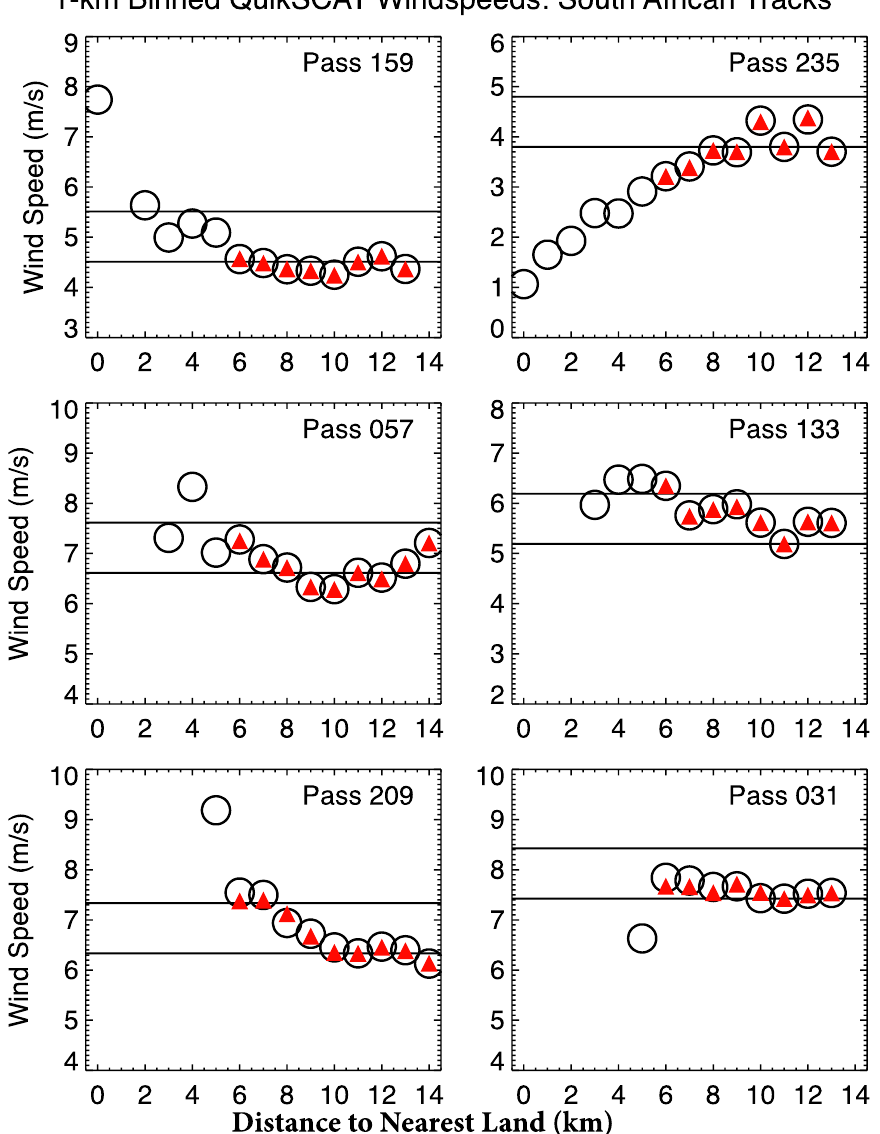
Figure 8. Scatterometer wind speeds from L2B retrievals within the 7 × 13 km bin nearest to the coast (the rectangles in Figure 7), averaged into 1-km bins based on the distance from the L2B vector wind retrieval to the nearest land. All seasons are included. Black circles are the averages of all points within the 1-km bin within the rectangle; red triangles exclude those identified by the PCP flag as suspect, including all points within 5 km of land. The two horizontal lines are separated by 1 m/s, while the lower of the two lines passes through the wind speed value at 11 km from the nearest land.